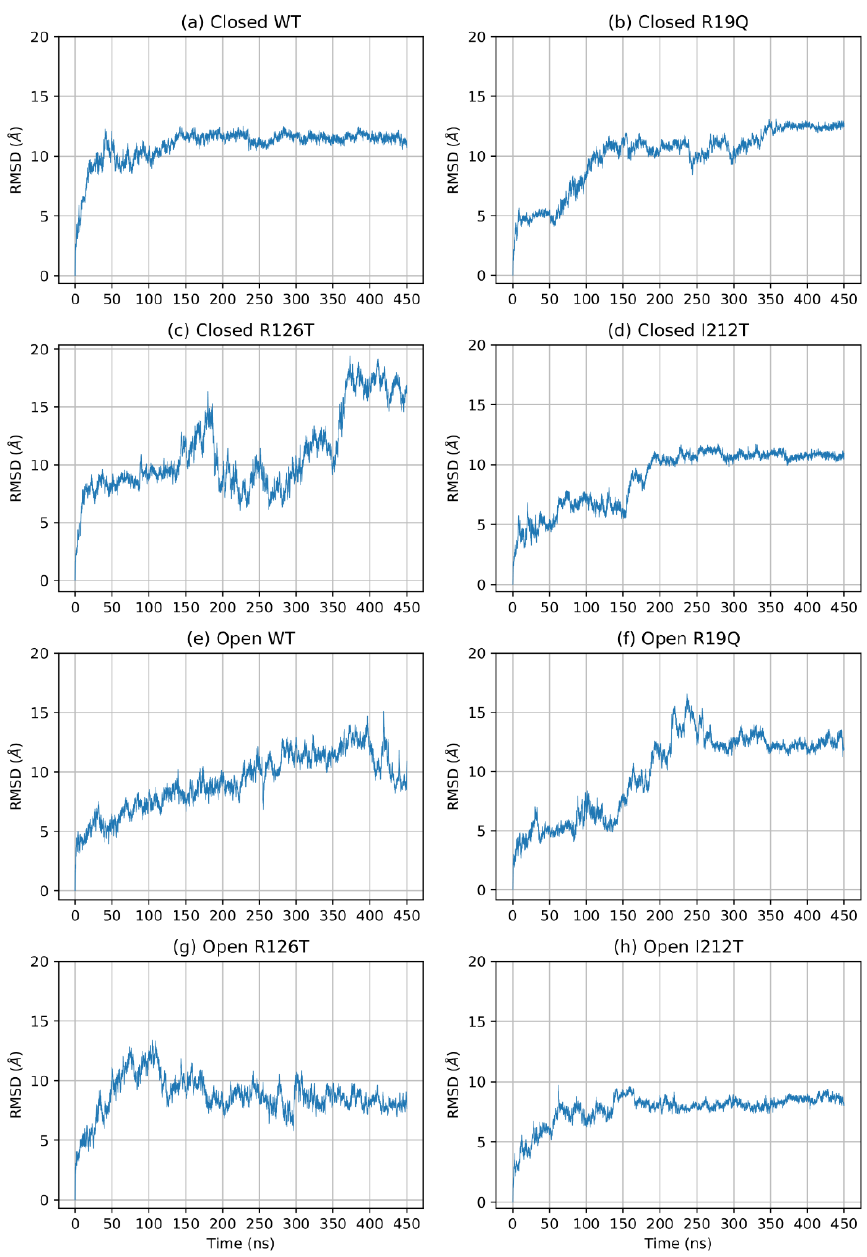
Figure 1. RMSD of C α of the entire protein during simulation. Figure 1. RMSD of Cα of the entire protein during simulation Table 1. Equilibration points set for trajectories of different structures. Table 1. Equilibration points set for trajectories of different structures.